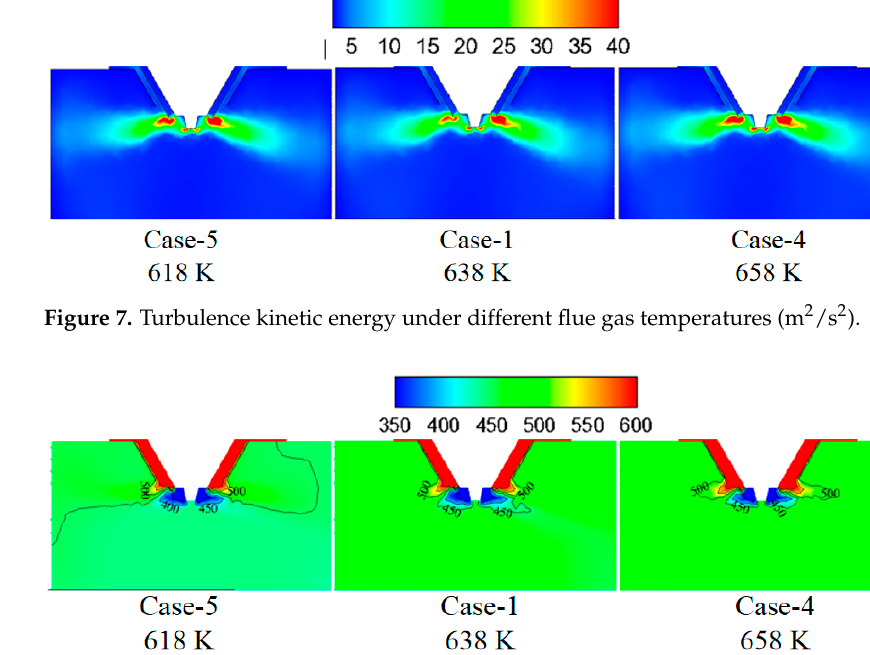
Figure 6. Effect of flue gas flow rate on evaporation performance.